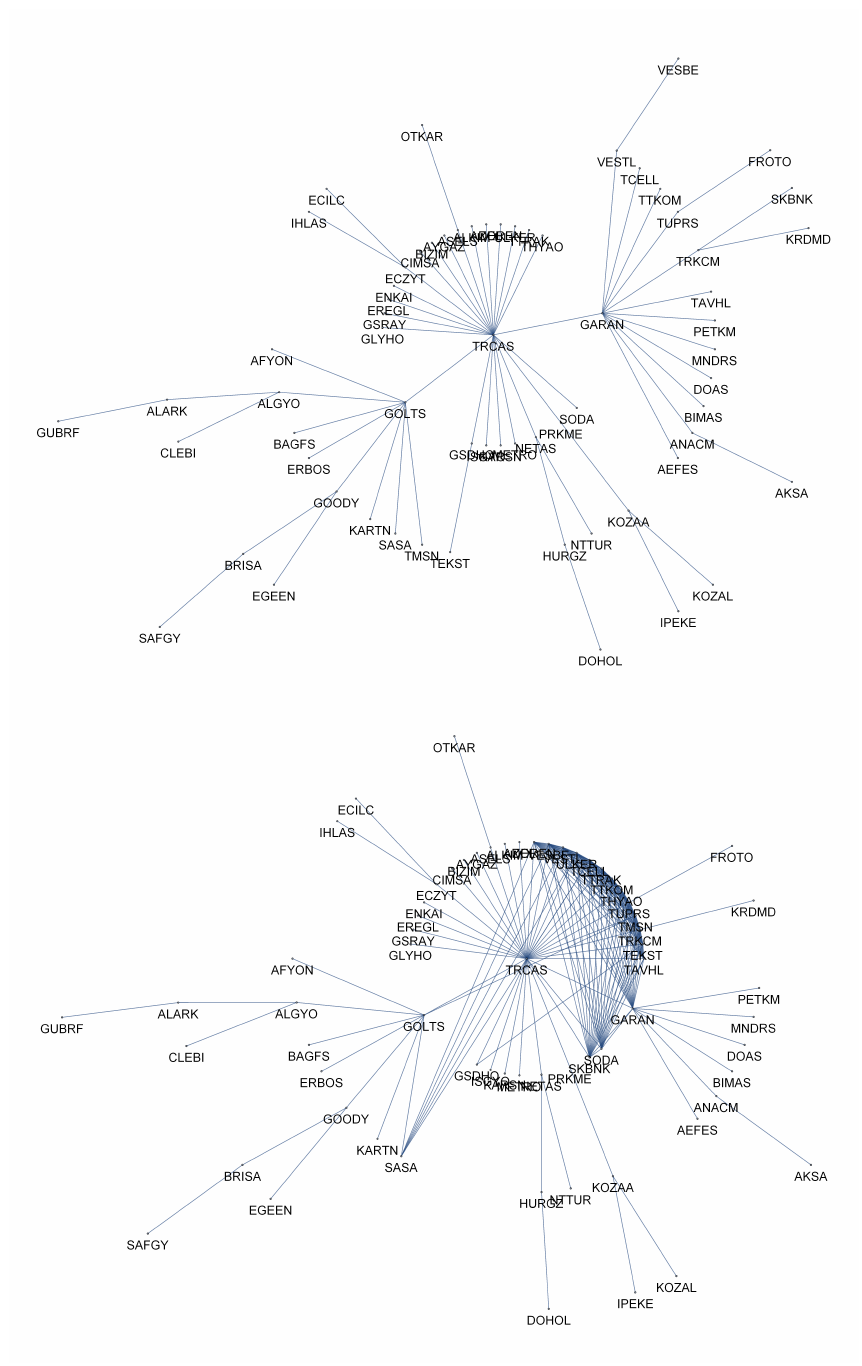
Fig. 4 MST (above) and PMFG (below) filtering of Community